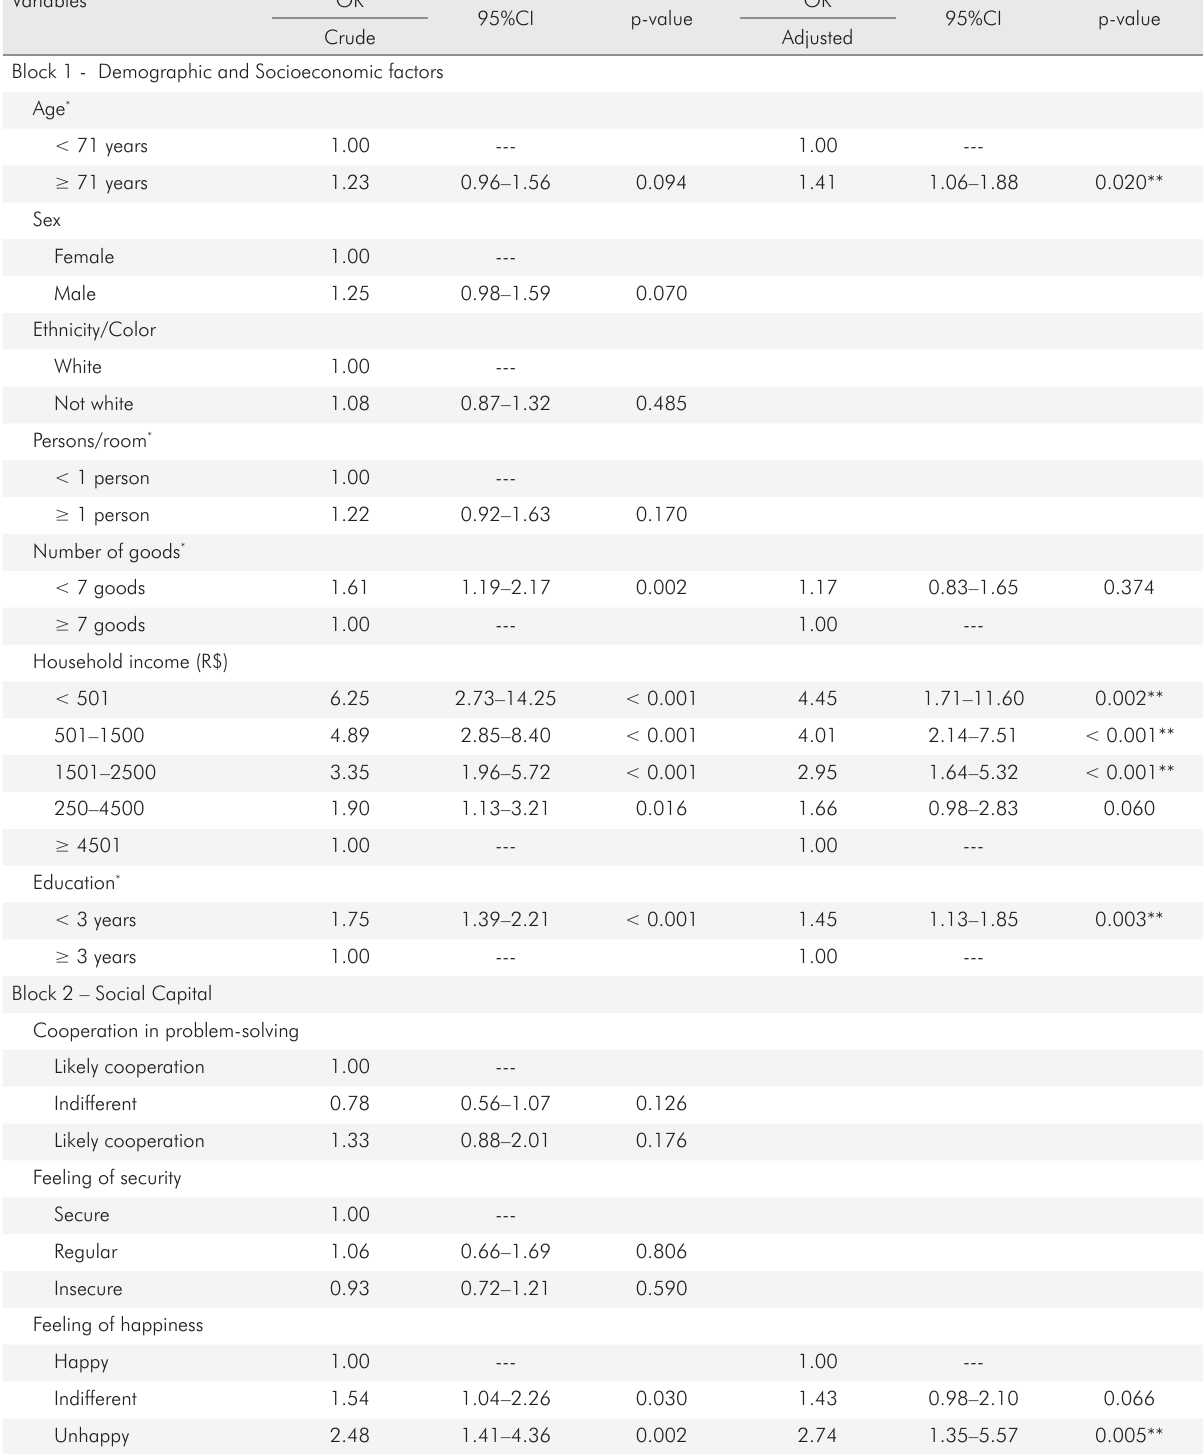
Table 3. Crude and adjusted analysis of the model of multinomial logistic regression for need for complete denture in both arches among elderly residents in State of São Paulo, Brazil, 2015 (n = 5,948).